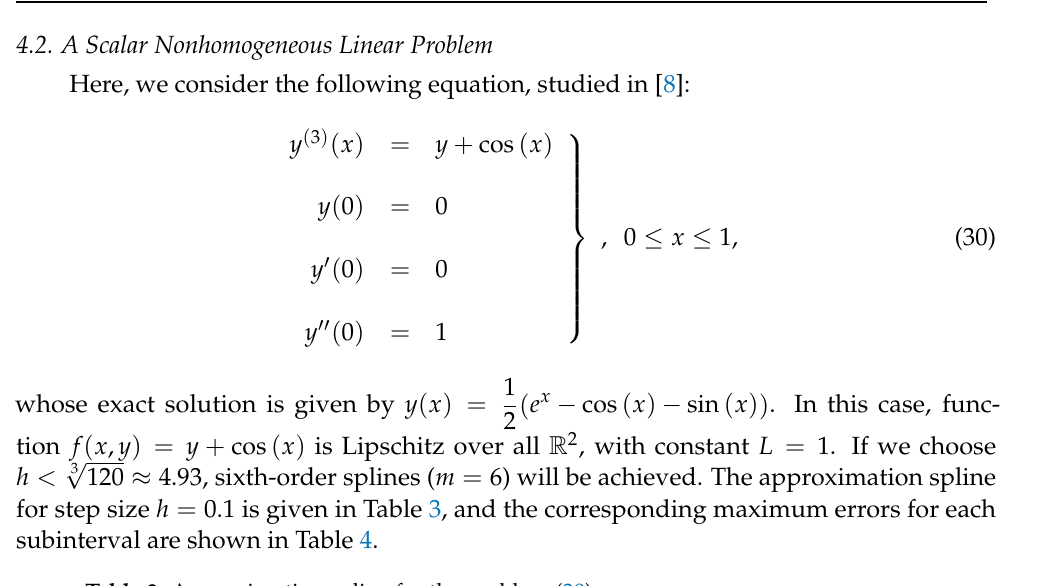
Table 3. Approximation spline for the problem